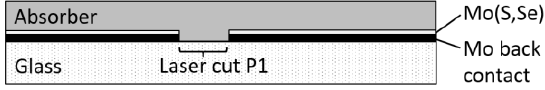
Figure 2. P1 laser Figure 2. P1 laser cut. Figure 2. P1 laser cut.